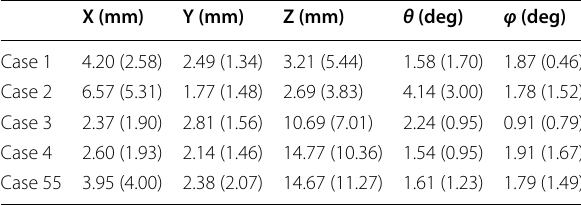
Table 1 Result of the accuracy of roller pose